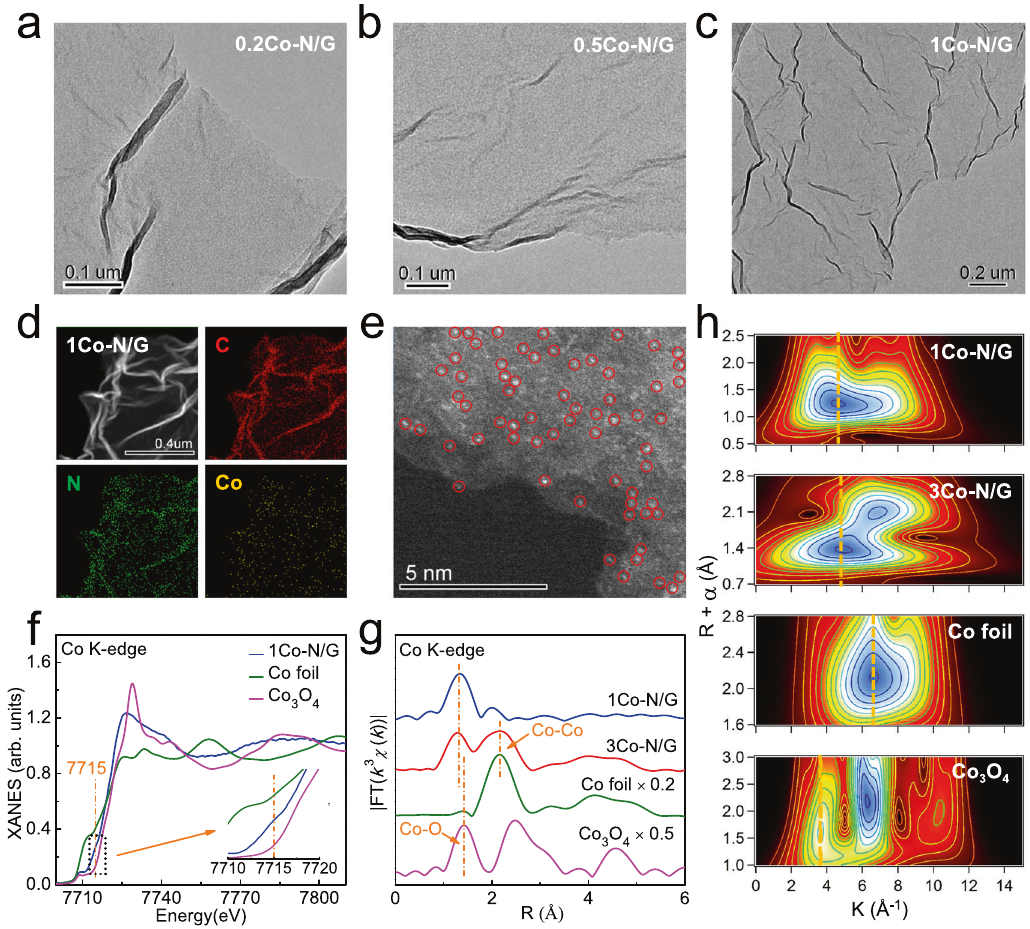
Fig. 1 Atomic dispersion of Co atoms. TEM images of a 0.2Co-N/G, b 0.5Co-N/G, and c 1Co-N/G samples. d EDX elemental mapping and e HAADF- STEM image of 1Co-N/G; bright red circles represent isolated Co atoms. f Co K-edge XANES spectra for 1Co-N/G and reference samples. g FT k 3 -weighted Co K-edge EXAFS spectra and h WT analysis of EXAFS spectra for 1Co-N/G, 3Co-N/G, and reference